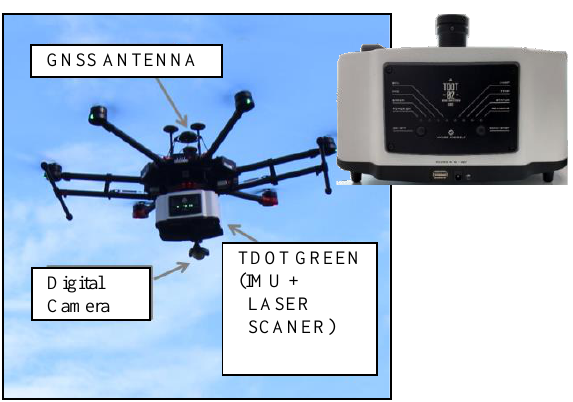
Figure 1. External appearance of